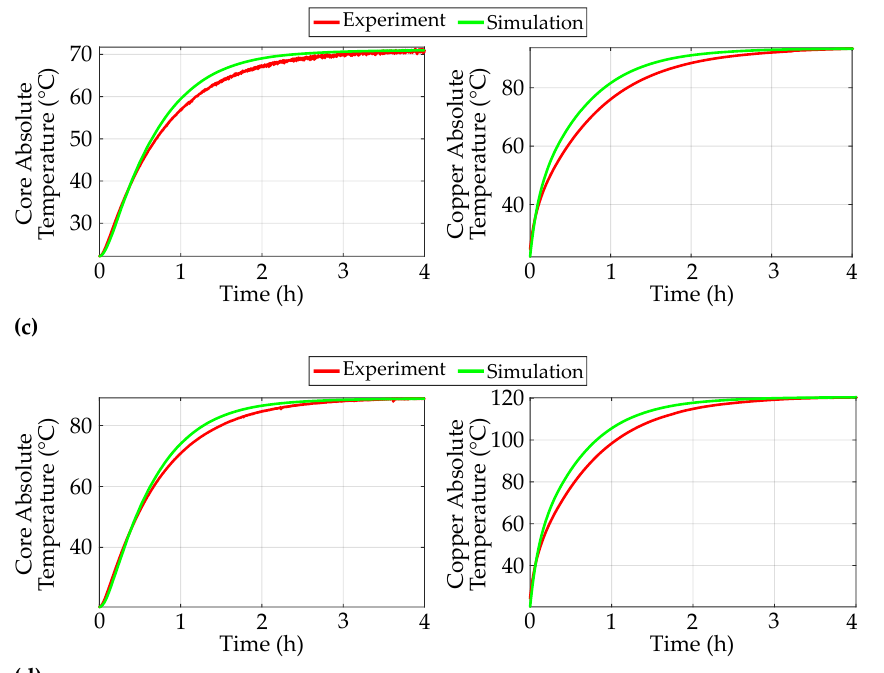
Figure 13. LIM thermal test result vs model response. ( a ) Horizontal test. ( b ) Vertical test. ( c ) Vertical test with aluminium plate at 135 W. ( d ) Vertical test with aluminium plate at 195 W.